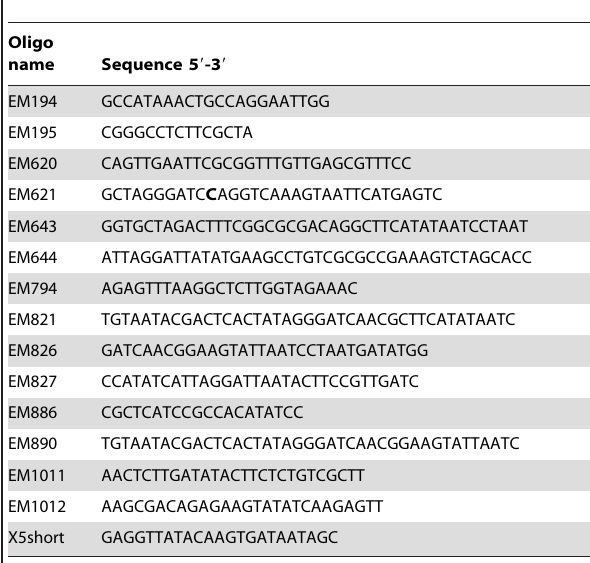
Table 1. Oligonucleotides used in this